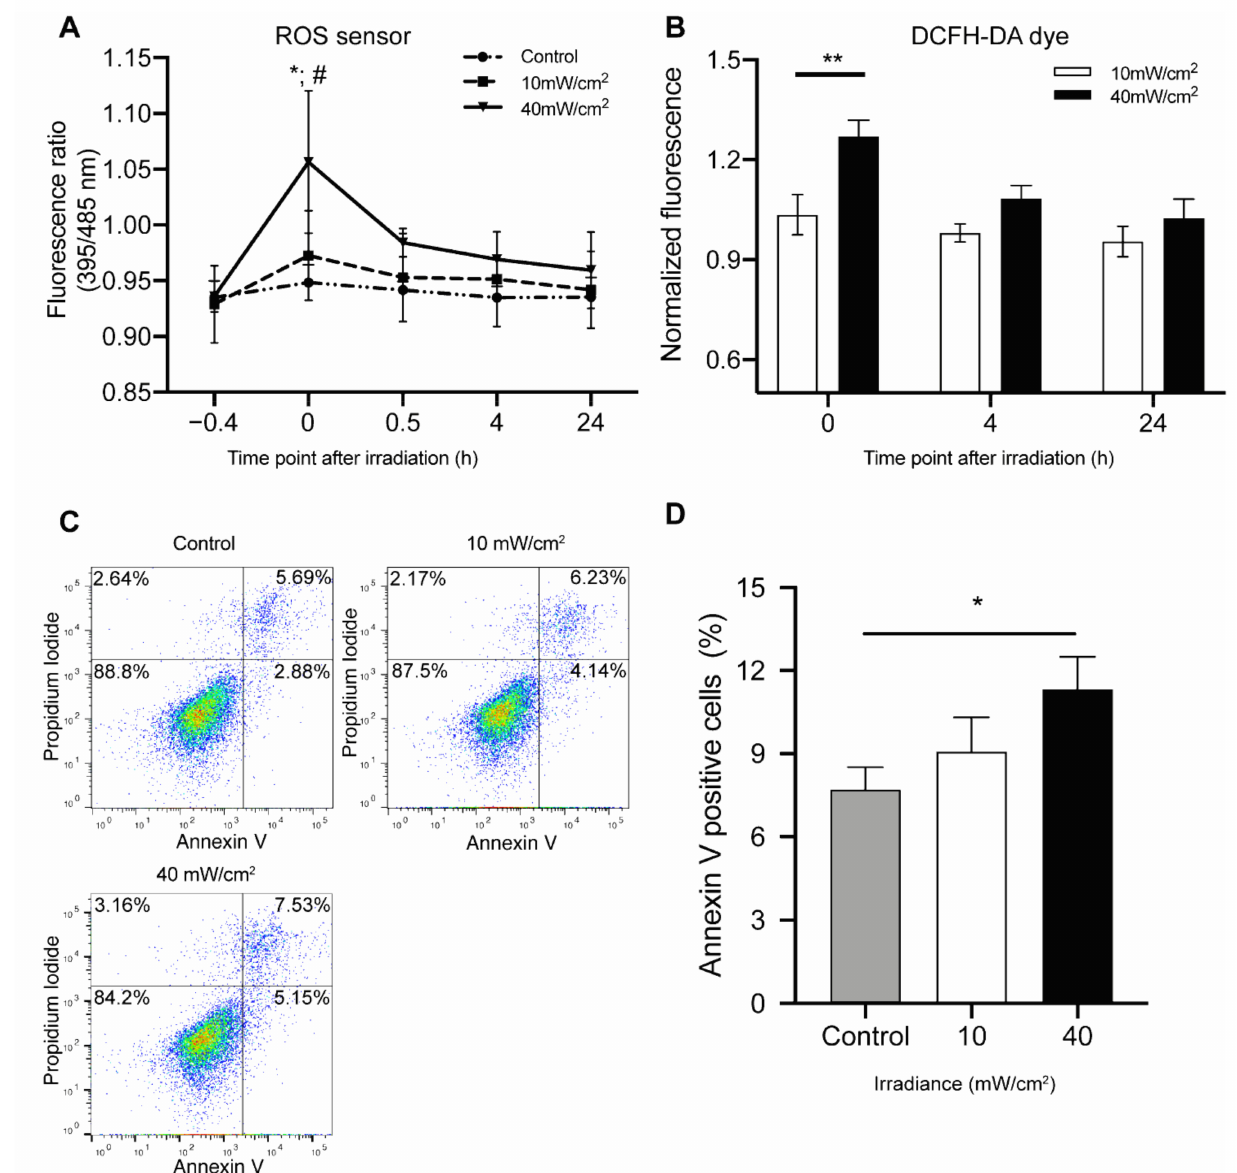
Figure 2. Blue light affects intracellular reactive oxygen species (ROS) production and apoptosis: ( A ) Dynamic ROS changes of HUVECs with redox sensor following blue light exposure to either low fluence (10 mW/cm 2 × 12 min) or high fluence (40 mW/cm 2 × 12 min). Data are shown as mean ± SD ( n = 3 repetitions, * p < 0.05: 40 mW/cm 2 vs. 10 mW/cm 2 , # p < 0.05: 40 mW/cm 2 vs. control, two-way ANOVA) ( B ) Changes in the ROS levels in HUVECs following exposure to either low fluence (10 mW/cm 2 × 12 min) or high fluence (40 mW/cm 2 × 12 min), as evidenced by Dichloro-dihydro-fluorescein diacetate (DCFH-DA) assay after irradiation. Fold change was calculated versus non-irradiated controls. Data are shown as mean ± SD ( n = 3 repetitions, ** p < 0.01, two-way ANOVA). ( C ) Representative results of Annexin V PI staining of HUVECs following exposure to either low fluence (10 mW/cm 2 × 12 min) or high fluence (40 mW/cm 2 × 12 min) measured by flow cytometry at 24 h after irradiation. ( D ) Quantification of cell apoptosis induced by blue light. Annexin V+/PI − and Annexin V+/PI+ populations were considered as apoptotic cells. Data are shown as mean ± SD ( n = 3 repetitions. * p <